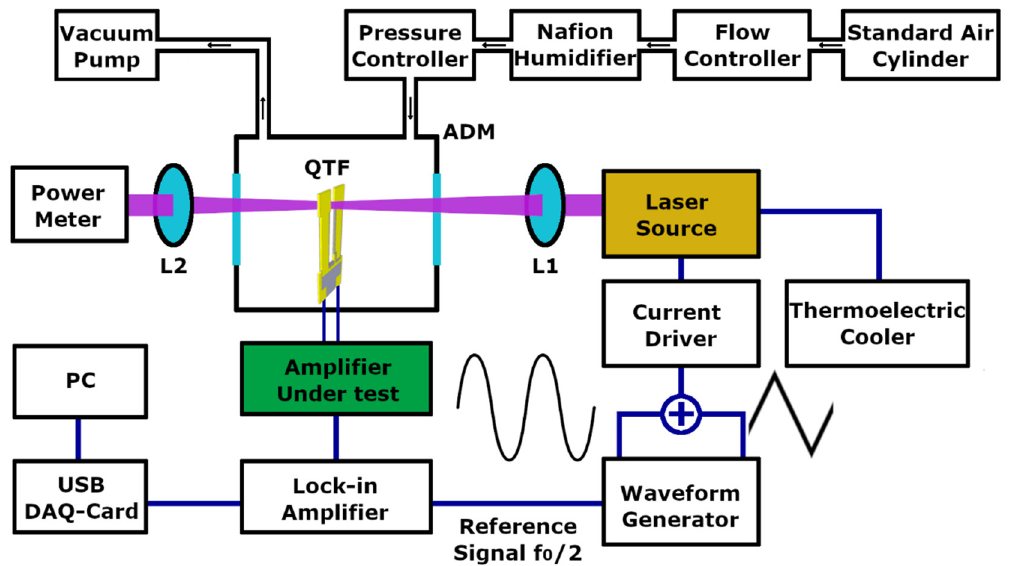
Figure 3. Schematic of the experimental apparatus. ADM—acoustic detection module, QTF—quartz tuning fork, L1, L2—lenses, PC—personal computer.